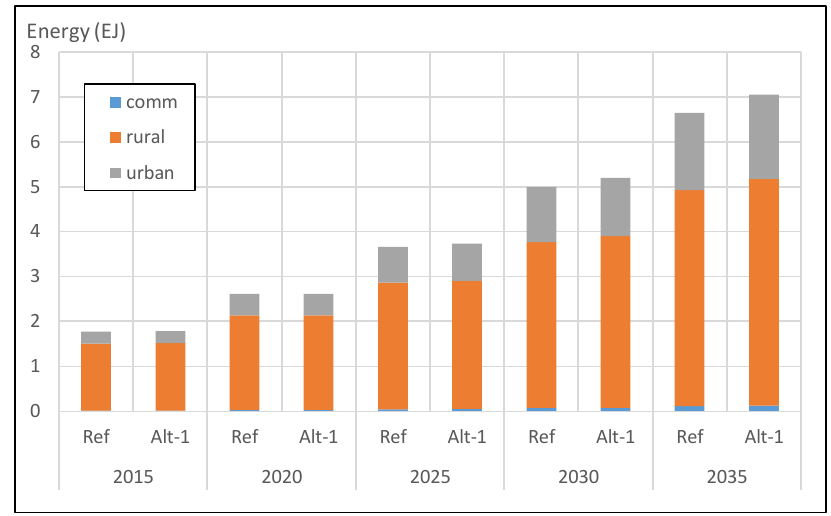
Figure 7. Distribution of Building Energy Demand for the Ref. and Alt-1 Scenarios (Unit: EJ).